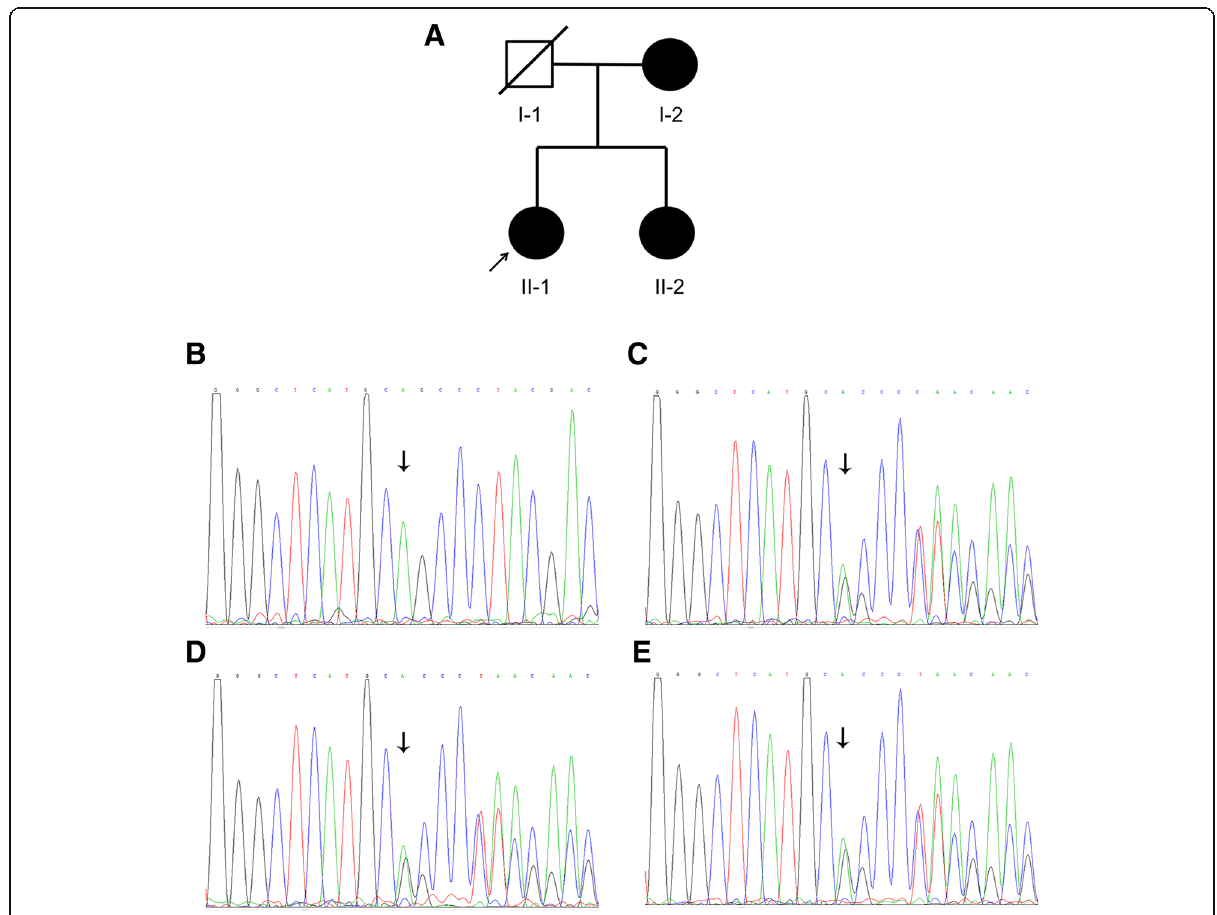
Fig. 1 Pedigree and sequence analysis of the PITX2 gene in a Chinese family with Axenfeld-Rieger syndrome. a Roman numerals refer to generations, and individuals within a generation are numbered from left to right. Proband II-1 is noted with an arrow; the filled symbol refer to the patients; and the slash refers to the dead individual. b - e , the DNA sequence of the CHM c.280delA mutation in the normal control ( b ) and the patients ( c , I-2; d , II-1; and e , II-2). The arrow indicates the mutated